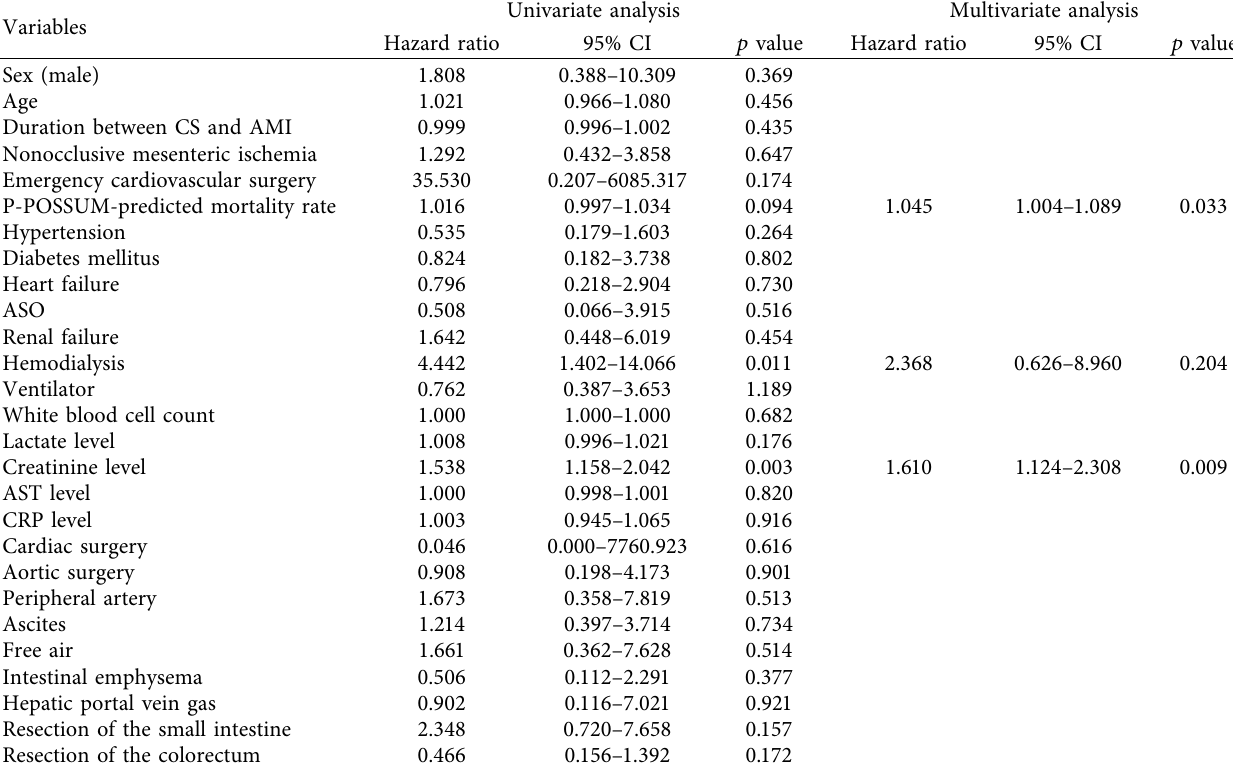
Table 4: Cox proportional hazard regression analysis of mortality.